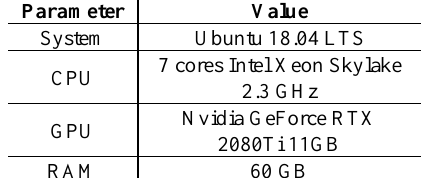
Table 2. Parameters of the virtual machine on which the experiments were